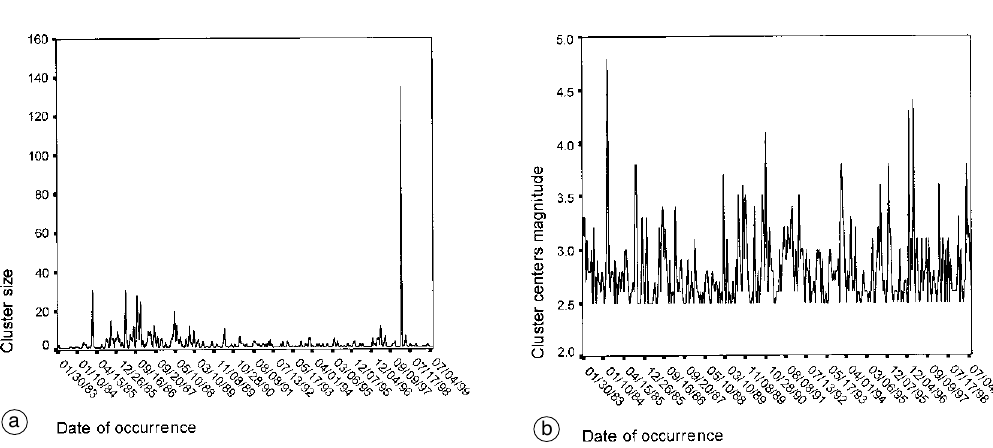
Fig. 9a,b. a) Sequence graph of cluster sizes (a total of 346); b) sequence graph of magnitudes of cluster centers.